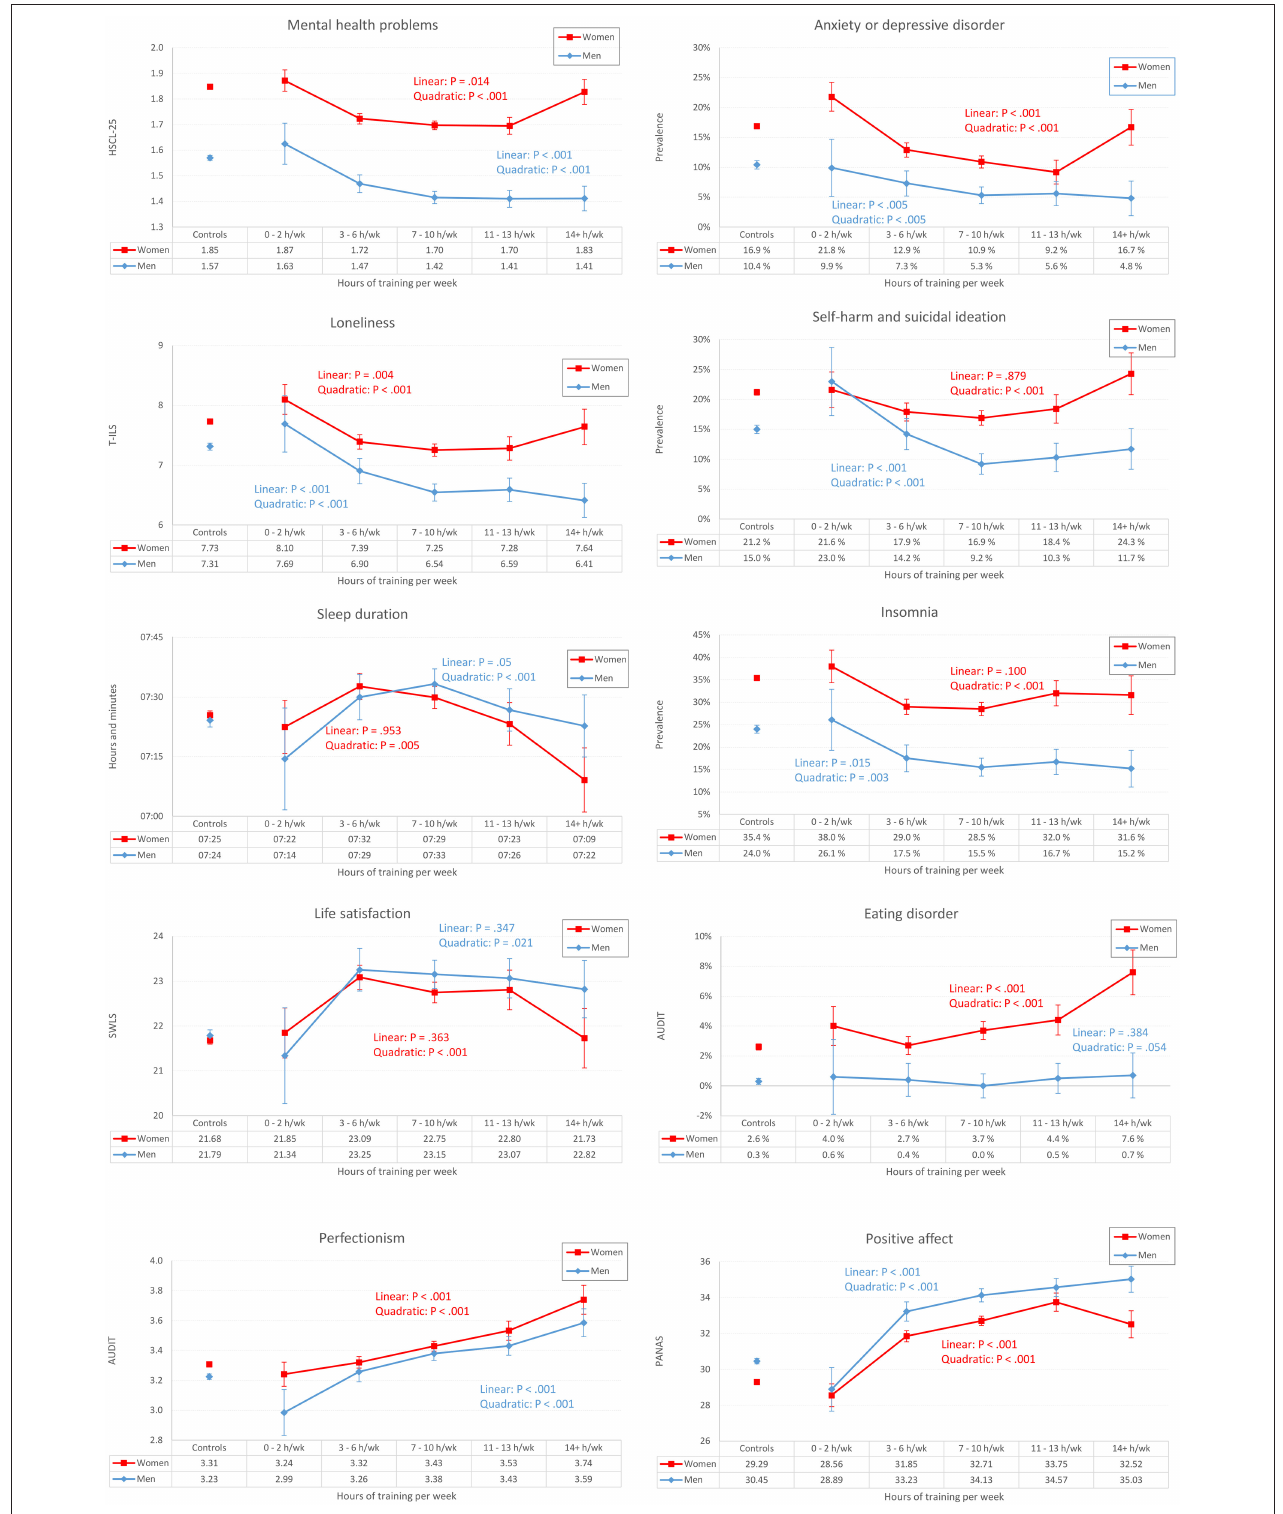
FIGURE 3 | Hours of training (X axis) and age-adjusted health indicators (Y axis) in male and female college and university students exercising “almost every day” (not just elite athletes). The unconnected point estimates (to the left on each panel) represent students training 2–3 days/wk or less. Error bars represent 95% confidence